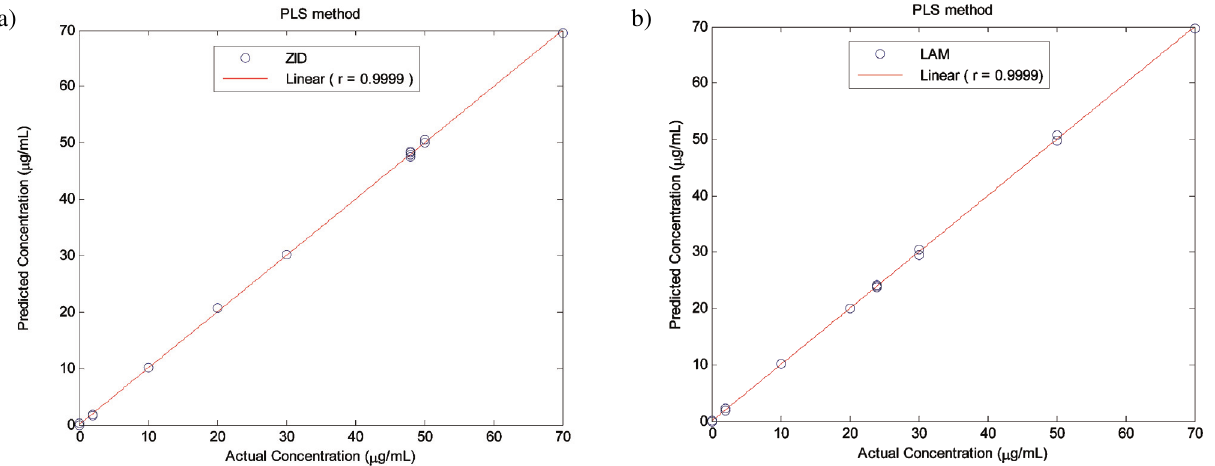
Figure 2. Plot of the actual and predicted concentrations in the calibration step by using the PLS method with four components for ZID (a) and LAM (b) drugs